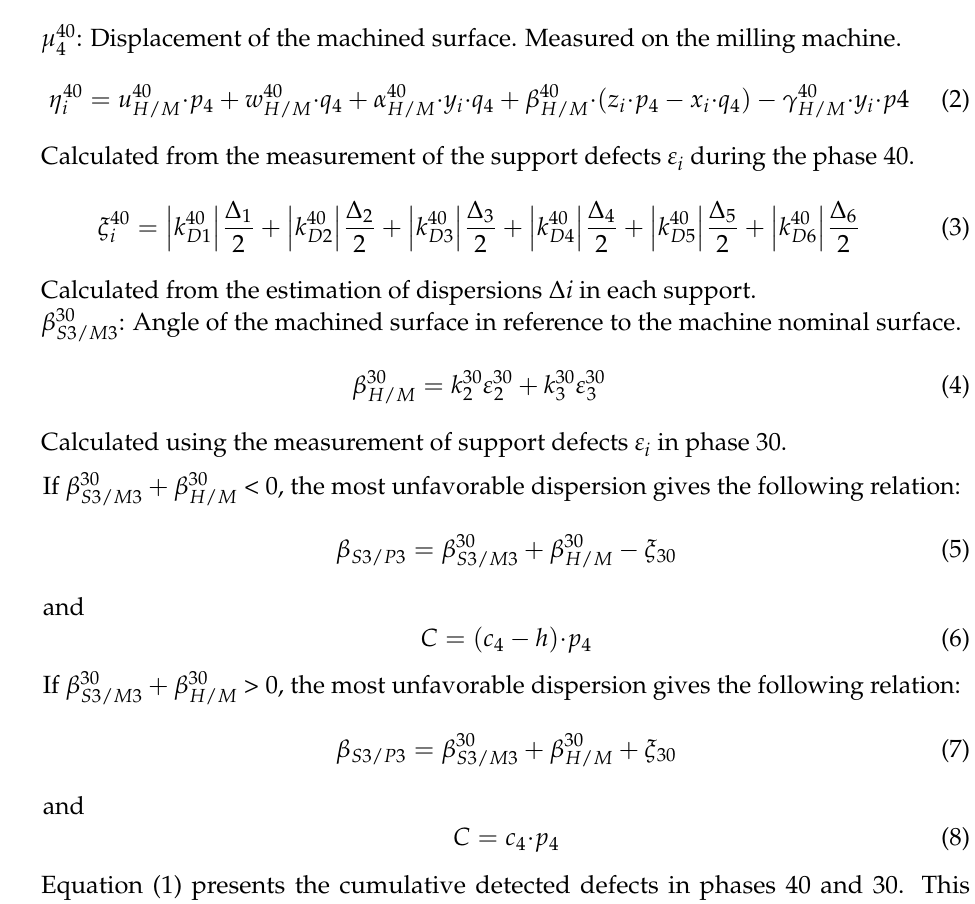
Figure 4. Positioning and manufacturing process.